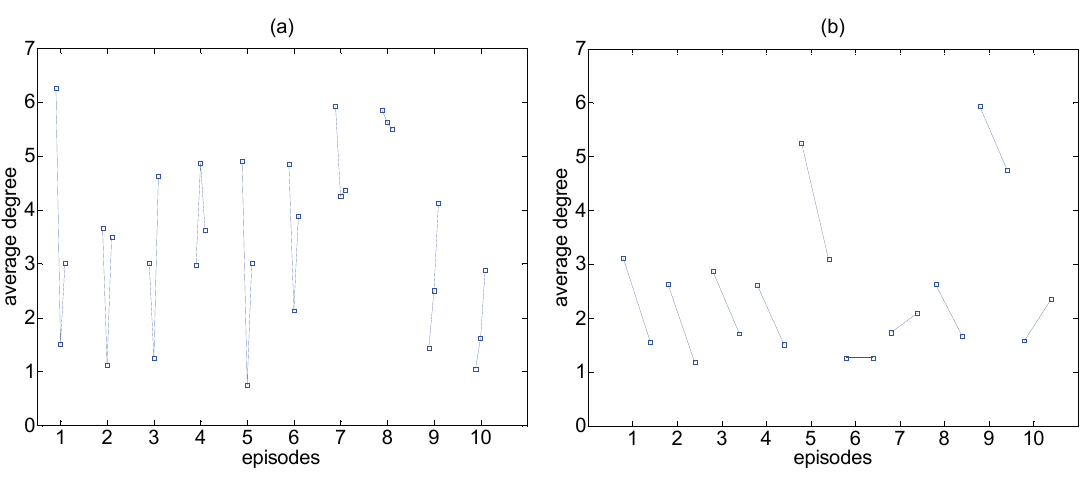
for the 10 episodes with TMS (the three values at each episode correspond to preED, preTMS and postTMS) in ( a ) and the 10 episodes without TMS (the two values correspond to preED and ED) in ( b